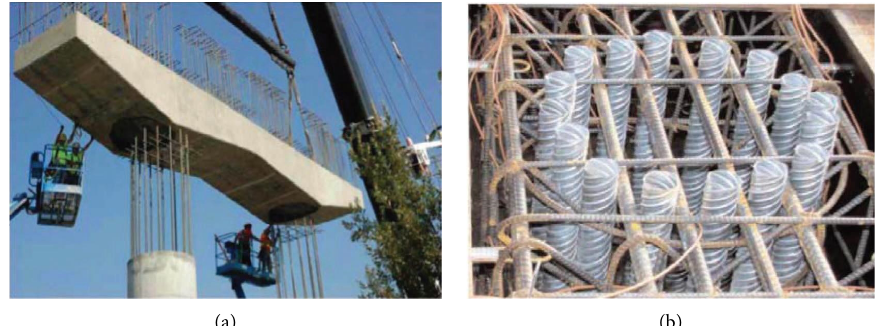
Figure 1: Prefabricated piers and columns connected with corrugated pipes [2]. (a) Prefabricated piers. (b) Corrugated